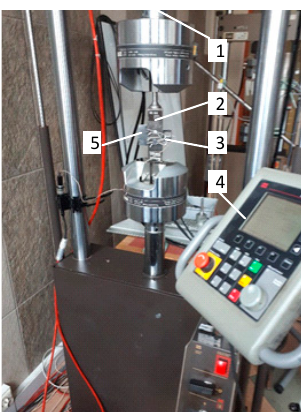
Figure 4. FCGR (Fatigue Crack Growth Rate) test specimens. ( a ) CT (Compact Tension) specimen scheme and dimensions (in mm) for mode I test; ( b ) CTS (Compact Tension Shear) specimen scheme and dimensions (in mm) for mixed mode I + II test.